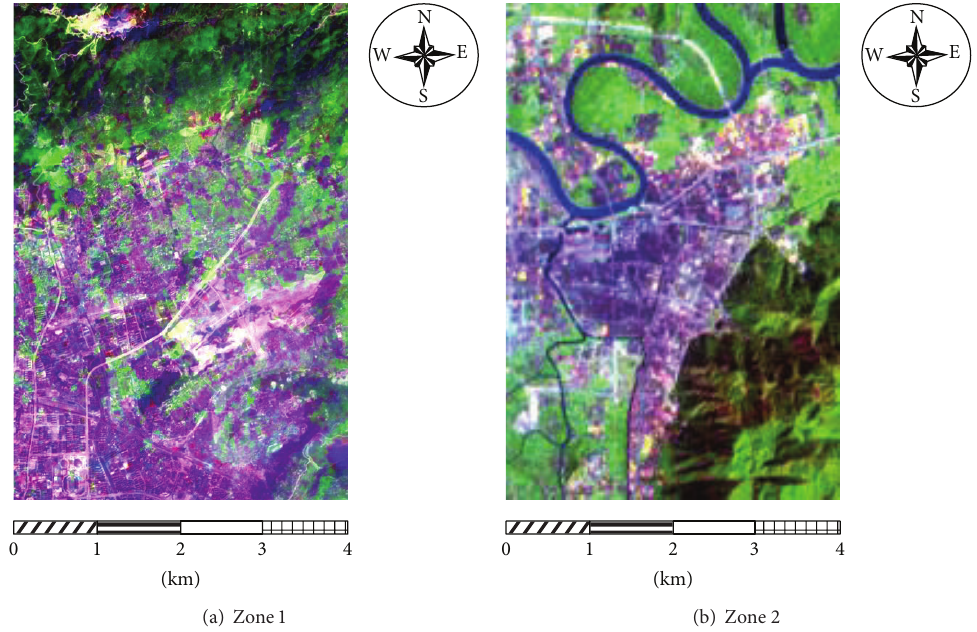
Figure 5: Results of fusing images in the two